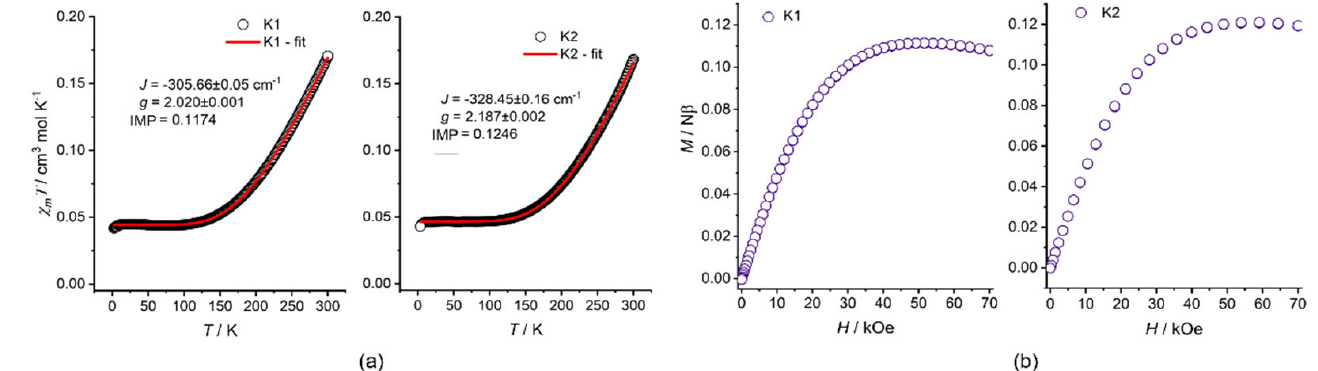
Figure 7. Magnetic properties of K1 and K2 : ( a ) χ M T plots at H dc = 5 kOe together with the PHI fits and values of J Cu ‐ Cu and g Cu,avg ; ( b ) M ( H ) plots at T = 1.8 K.